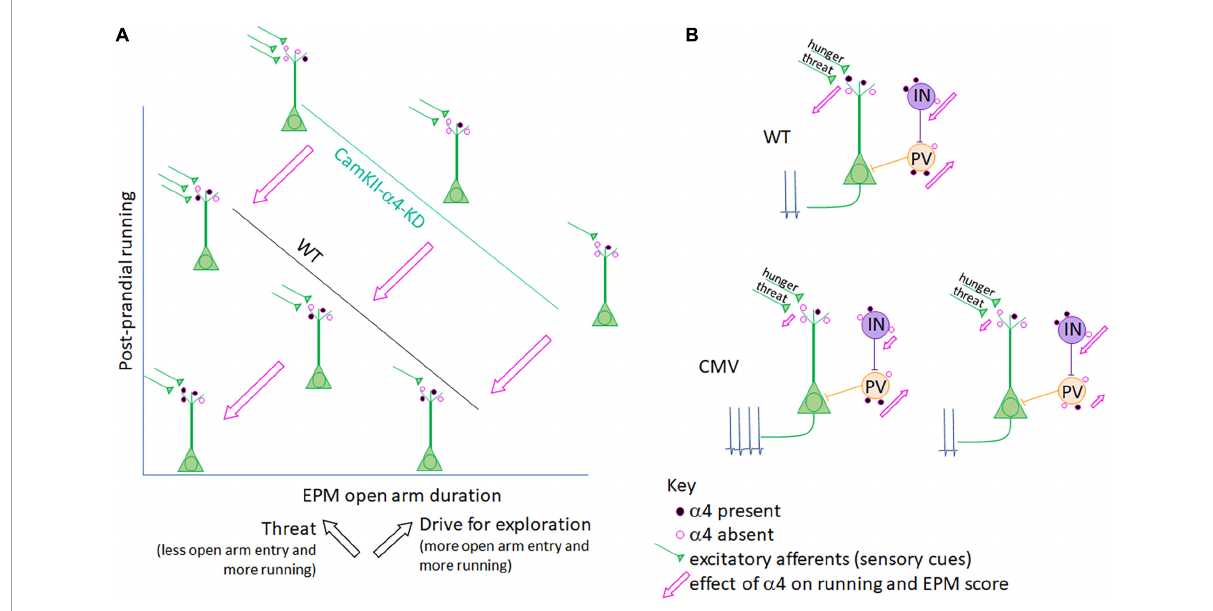
FIGURE3 Interpretation of a α 4 co-regulation of running and anxiety/exploration in ABA mice. (A) Axes and line plots for CaMKII α promoter-driven a4-knockdown (KD) mice (teal line) and LoxP-negative wildtype littermates (WT, black line) are an abstraction of Supplementary Figure 1C , depicting a negative correlation for both groups between post-prandial running and the amount of time mice venture into the open arm of the elevated plus maze (EPM). While the EPM is most commonly used as a measure of anxiety-like behavior, it is important to note that hunger, while itself a stressor, promotes exploration (Atalayer and Rowland, 2011; Gutierrez, 2013; Chowdhury et al., 2021). Thus, the EPM score reflects both anxiety-like behavior (which is associated with ABA running) and exploration (also associated with ABA running; black arrows). α 4-KD specifically at excitatory synapses on pyramidal cells increases both running ( Supplementary Figure 1B ) and open arm entry ( Supplementary Figure 1C , Bar graphs), indicating that the presence of α 4 (represented by the filled pink circles on WT control mouse pyramidal cells) reduces running as well as open arm entry while still preserving the correlation between the two factors (pink arrows). In both WT and CaMKII α promoter-mediated α 4-KD mice, position along the correlation line is likely determined by input from excitatory afferents (green) to pyramidal cells which convey hunger and threat signals. The Aoki lab has shown that increased α 4 at excitatory synapses on hippocampal pyramidal neurons correlates negatively with running (Aoki et al., 2014, 2017) (lower left schematic, closest to where the two axes intersect), via the known mechanism of α 4 βδ -GABA A Rs to mediate shunting inhibition of pyramidal neurons (Shen et al., 2007, 2010). (B) When the target of α 4-KD is expanded from pyramidal cells to also include GABA-IN and astrocytes, as is the case in the CMV promoter-driven α 4-KD mice, the correlation between running and anxiety/exploration is lost. This may be because GABA-IN both directly inhibit pyramidal cell firing (as do PV cells, peach) as well as promote pyramidal cell firing via disinhibition (purple cell), both of which may be suppressed by α 4 βδ -GABA A Rs at excitatory synaptic inputs to GABA-IN and be de-suppressed by α 4-KD in GABA-IN. Net pyramidal cell firing, depicted by action potentials, would thus depend on the ratio of transduction in GABA-IN subtypes (lower level provides two examples). Pink arrows depict the effect of α 4 presence at excitatory synapses on running (y-axis) and EPM duration in the open arm (x-axis) in panel (A)